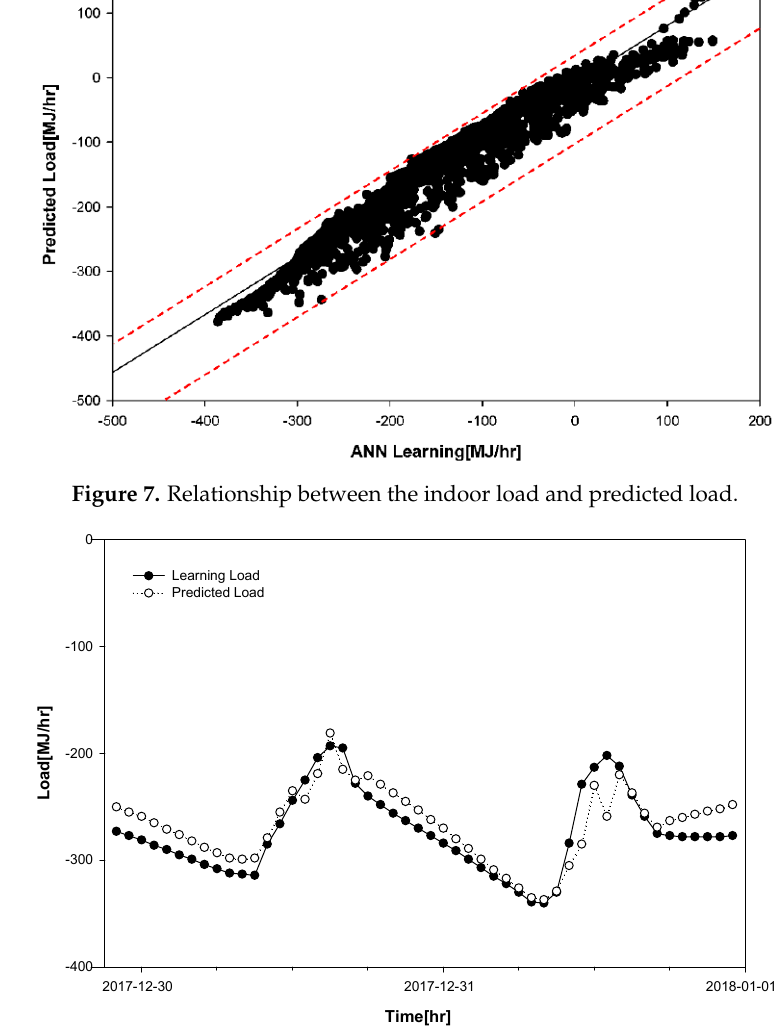
Figure 9. Energy Consumption for indoor load based on the supply air temperature.